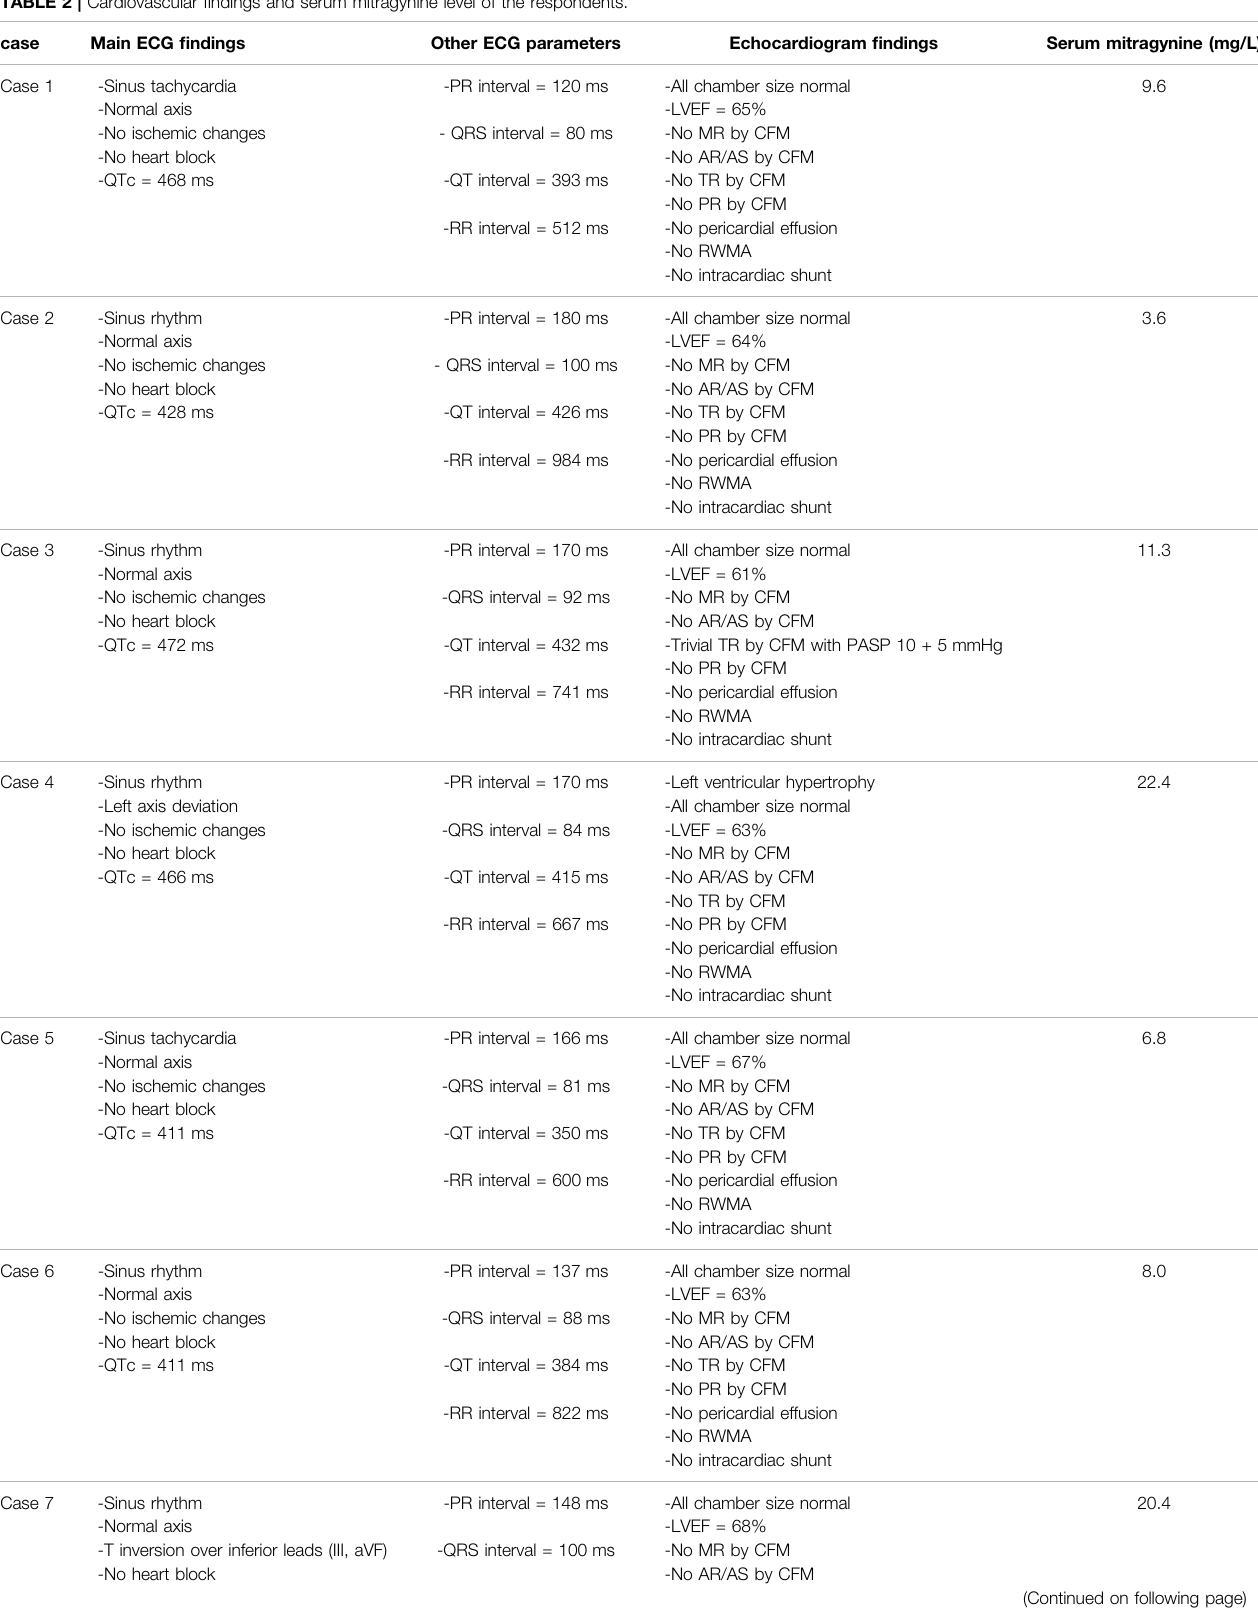
TABLE 2 | Cardiovascular fi ndings and serum mitragynine level of the